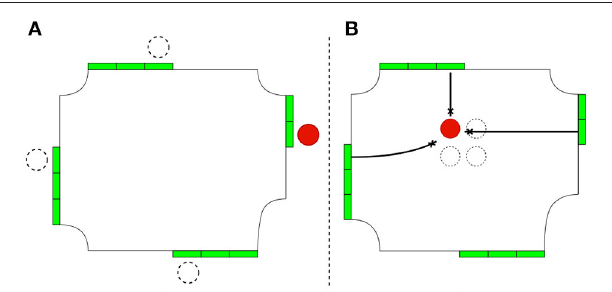
FIGURE 6 | This figure shows example placements of obstacles where the red circle represents the obstacle, while the dashed circles represent the possible alternative positions of the obstacle. The left part (A) shows in-lane obstructions, while the right part (B) shows in-intersection